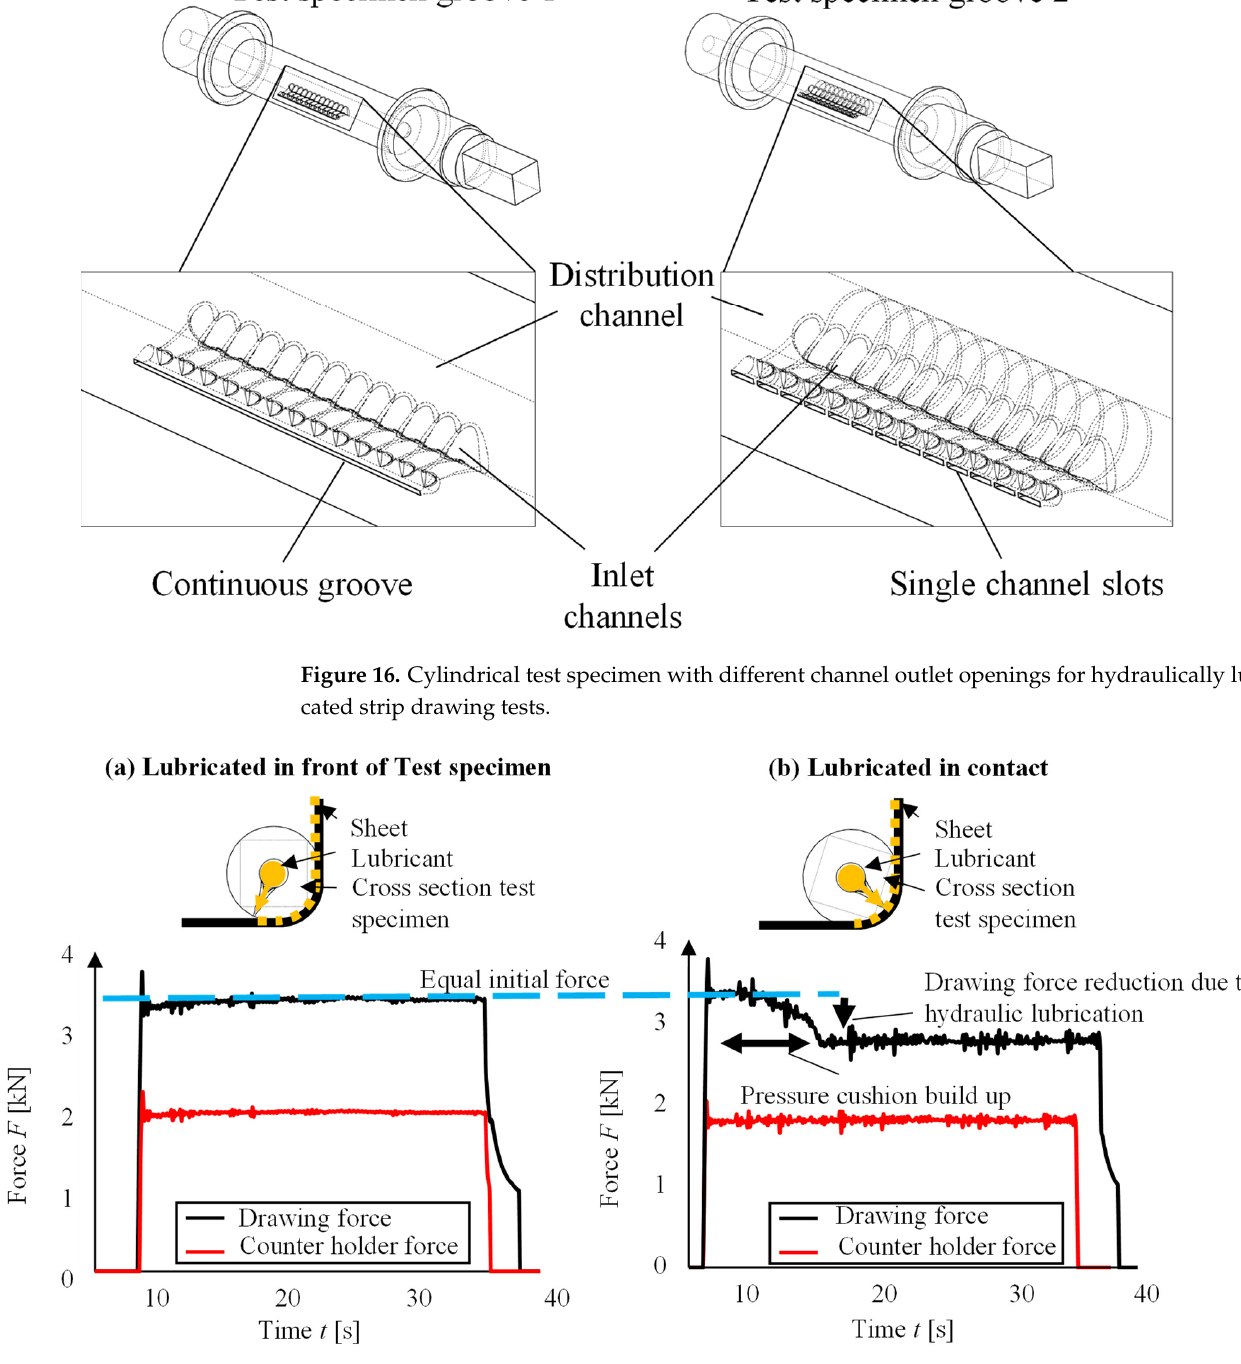
Figure 17. Force progression for in contact and in front of test specimen lubricated experiments.